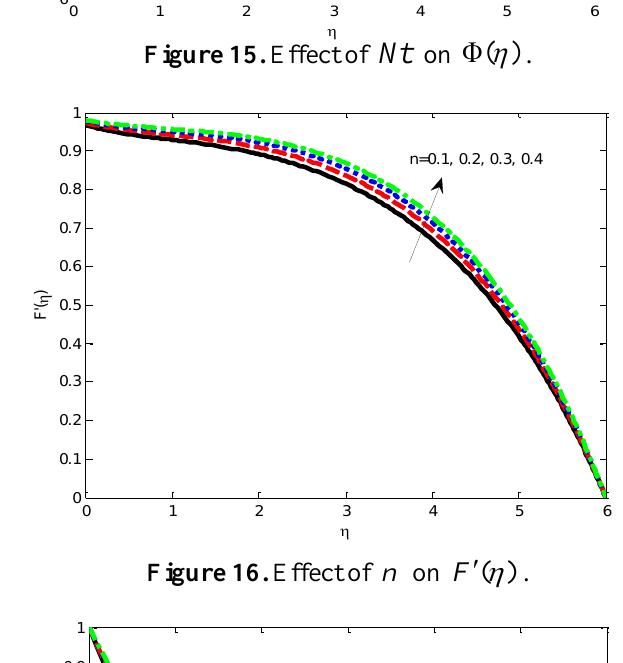
Figure 16. Effect of n on ( ) F  .